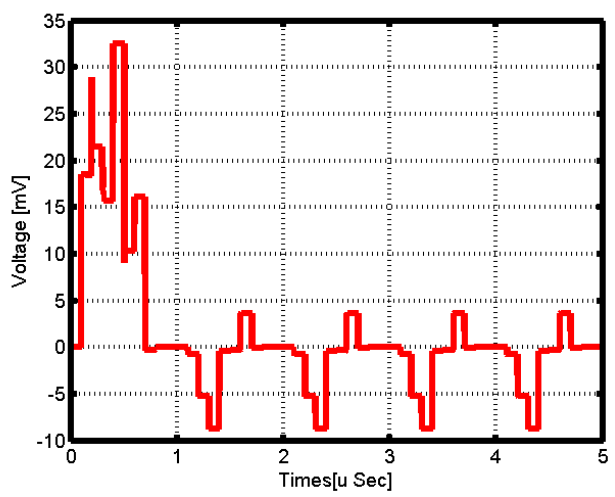
Figure 11. Integral non-linearity (INL) simulation for an eight level input memristor-based DAC circuit.